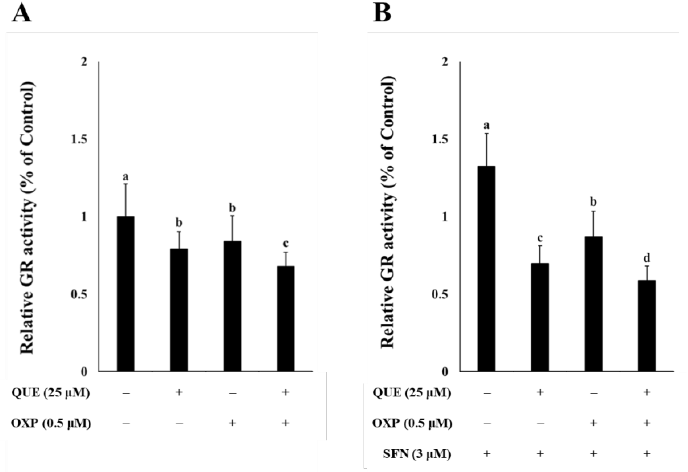
Figure 4. QUE and SFN in combination with OXP effectively inhibited GR activity in HCT116 cells. The cells were treated with different combinations of QUE and OXP in the absence ( A ) or presence of SFN ( B ) for 72 h. The GR activity was then measured and normalized to the total protein content. Error bars, mean ± SEM ( N = 3). Significant differences among treatments were denoted by different alphabetical letters ( p < 0.05, one-way ANOVA with Duncan’s post hoc HSD test). 3.4. Combined Treatment of QUE and OXP Decreased Intracellular GSH Level in HCT116 Cells As QUE was found to inhibit GR activity, it was expected that the intracellular GSH level would be decreased or depleted in QUE-treated cells. In order to examine the effects of the compound on the GSH level, HCT116 cells were exposed to QUE (25 μM), OXP (0.5 μM), and both (25 μM QUE plus 0.5 μM OXP) (Figure 5). Combined treatment with QUE and OXP significantly reduced GSH levels in HCT116 cells, although the individual compound did not have significant effect on intracellular GSH level (Figure 5A). It indicates that a combination of QUE and OXP are more effective in lowering the intracellular GSH level than the individual treatment in HCT116 cells. This observation was clearly manifest in the presence of SFN (Figure 5B).